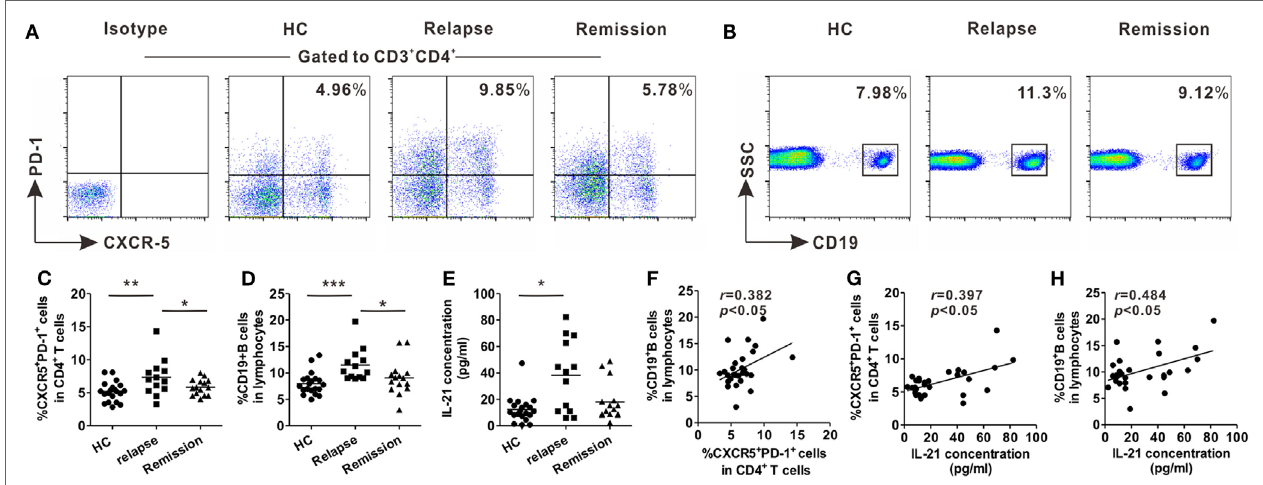
FigUre 1 | Increases in the percentages of circulating T follicular helper (Tfh)-like and B cells in relapsing-remitting MS (RR-MS) patients during the relapsing phase of the disease. Representative flow cytometry results of CD3 + CD4 + CXCR5 + PD-1 + Tfh-like cells (a) and B cells (B) in healthy controls (HCs), relapsing and remitting patients. Numbers in the upright corner illustrated the percentage of CXCR5 + PD-1 + cells in CD4 + T cells and the percentage of CD19 + B cells in lymphocytes. Comparisons of the frequencies of Tfh-like cells (c) and B cells (D) among HCs, relapsing patients and remitting patients. (e) Comparison of serum IL-21 level among HCs, relapsing patients, and remitting patients. (F) The correlation analysis between the frequency of Tfh-like cells and the frequency of B cells in patients with RR-MS. (g) The correlation analysis between the frequency of Tfh-like cells and serum IL-21 level in patients with RR-MS. (h) The correlation analysis between the frequency of B cells and serum IL-21 level in patients with RR-MS. Each data point represents an individual subject. The horizontal lines represent the mean values. HCs: n = 20; relapsing patients, n = 13; remitting patients, n = 15. * P < 0.05, ** P < 0.01, *** P <